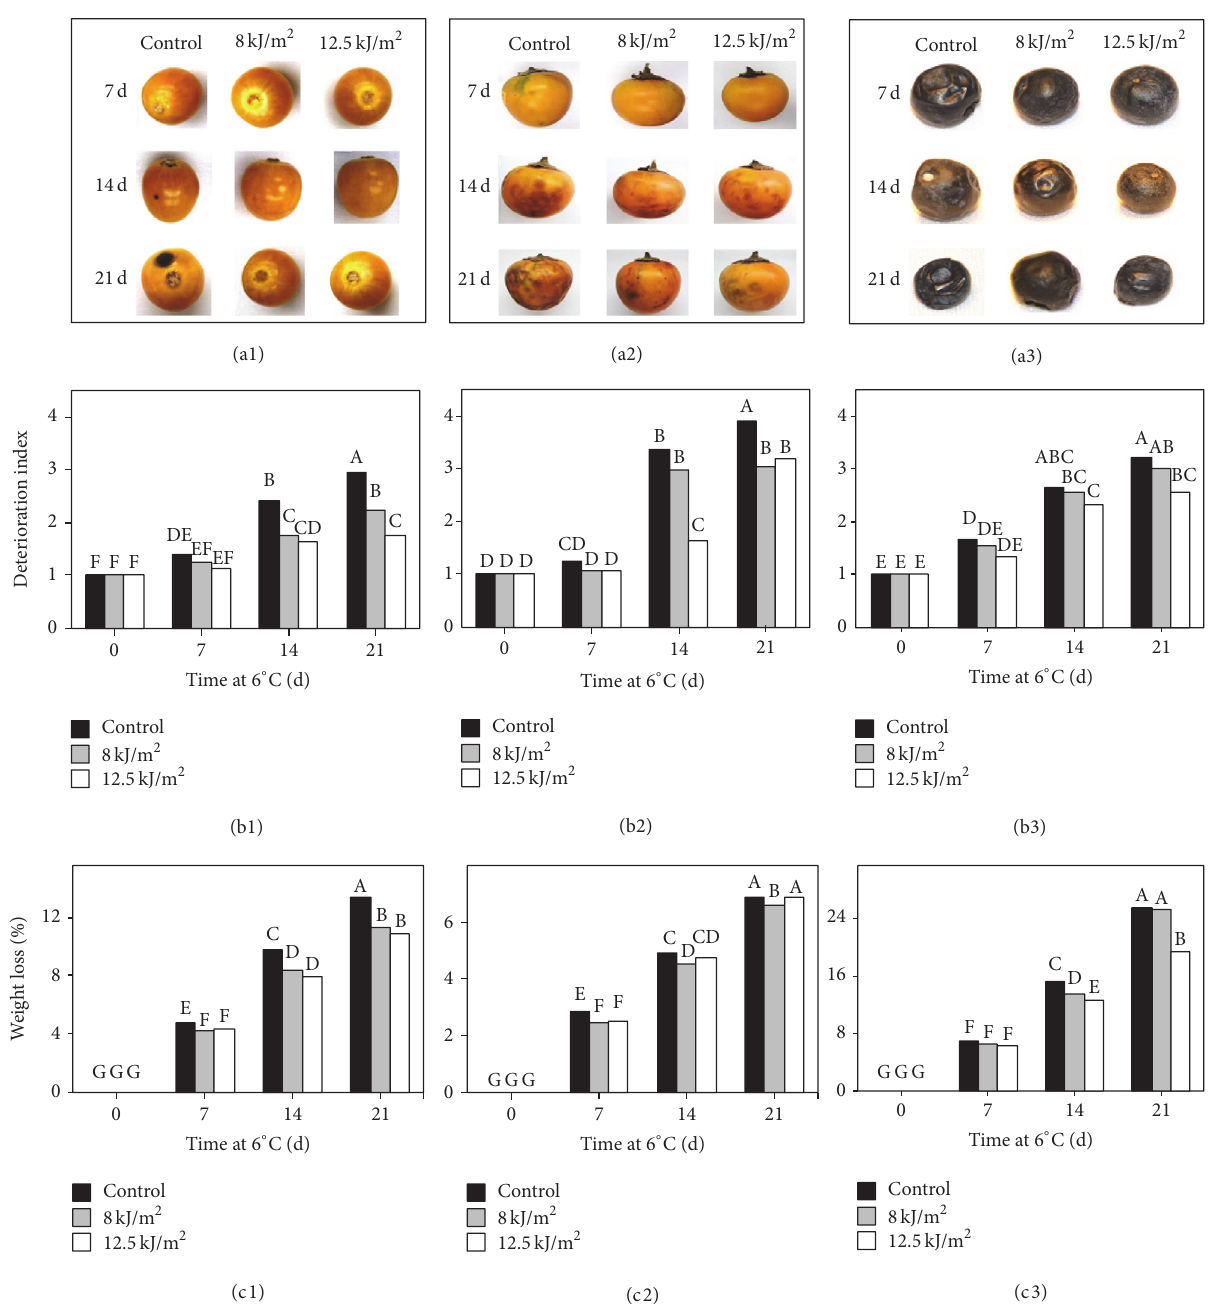
Figure 1: Appearance (a), deterioration index (b), and weight loss (%) (c) in control and UV-C treated (8 and 12.5 kJm −2 ) uvilla (left panels) ( 1 ), naranjilla (central panels) (2), and morti˜no (right panels) (3), stored at 6 ∘ C for 0, 7, 14, or 21 d. For each fruit, different letters between treatments show differences according to a Fisher test ( 𝑃 < 0.05